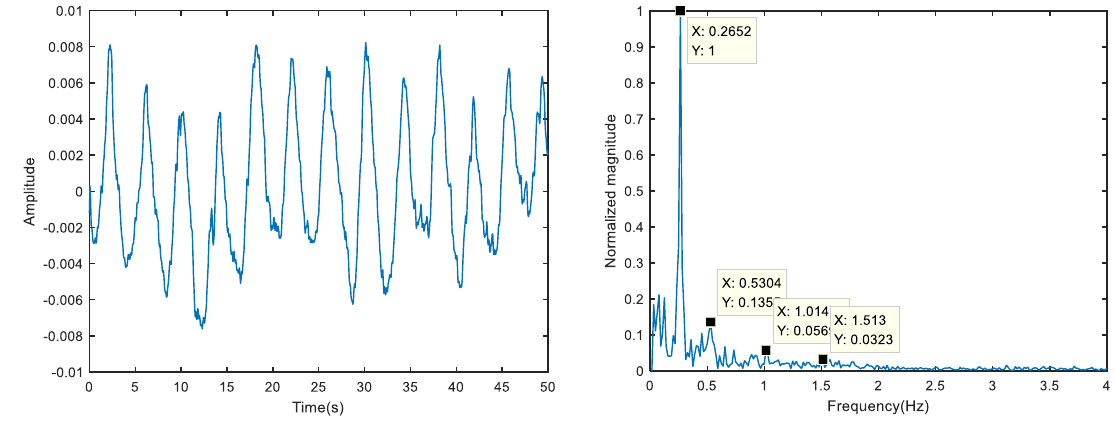
Figure 6. The original vital signs signal time domain and spectrum of target.